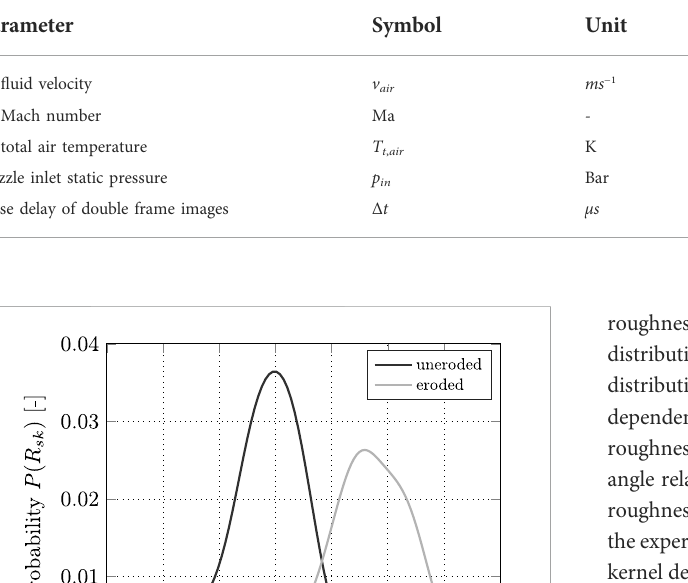
TABLE 2 Erosion test rig ’ s operation points.